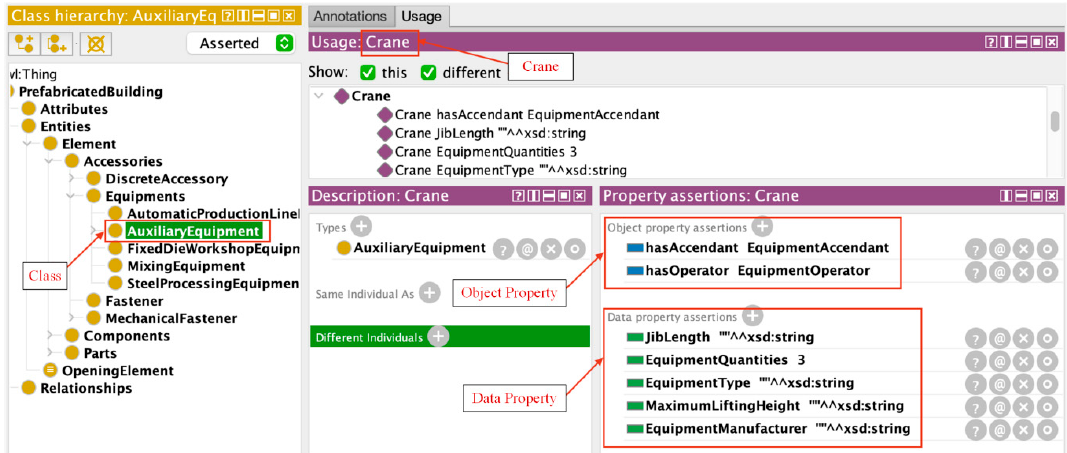
Figure 22. Component individual creation.